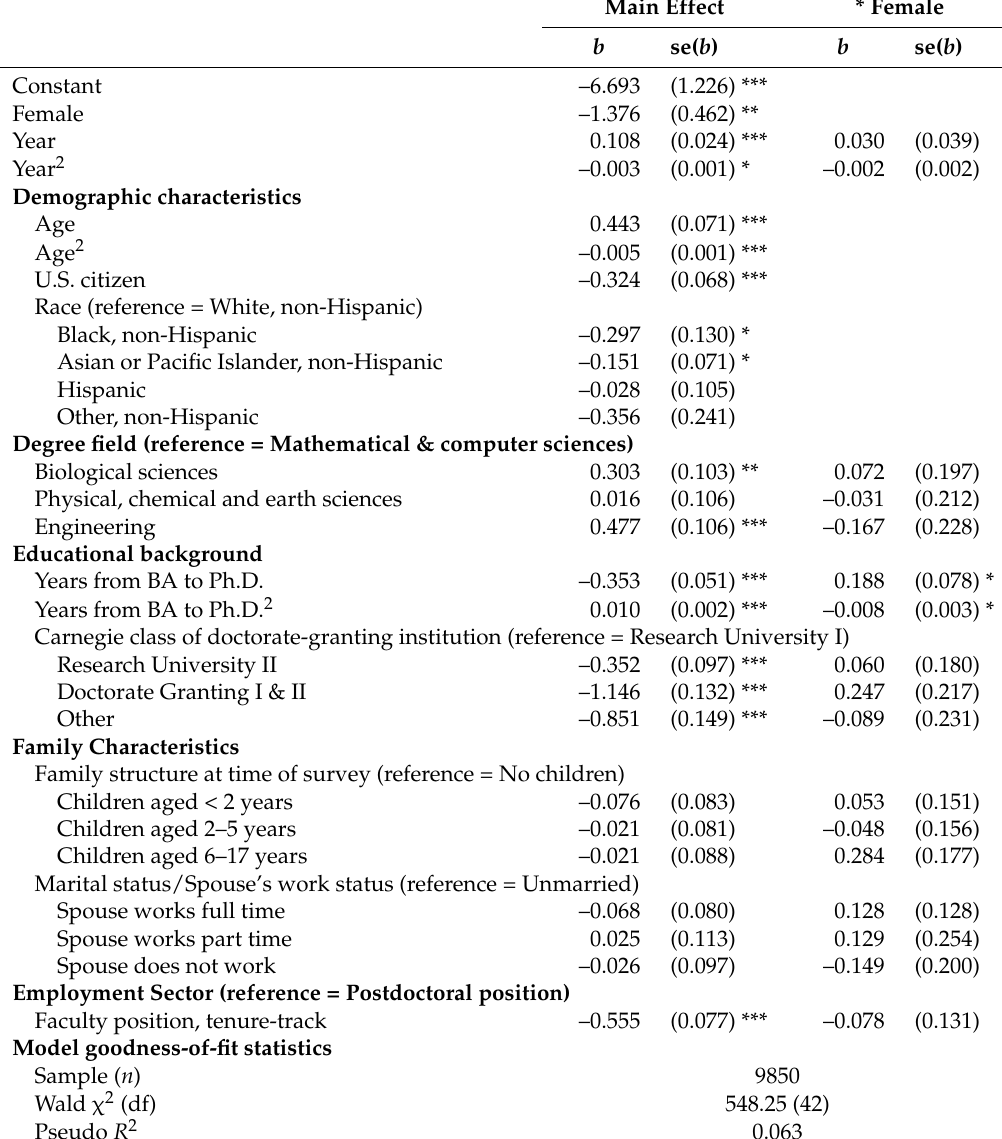
Table A4. Estimated coefficients from logit models of employment at a R1 or R2 university among those attaining a postdoctoral position or a tenure-track faculty